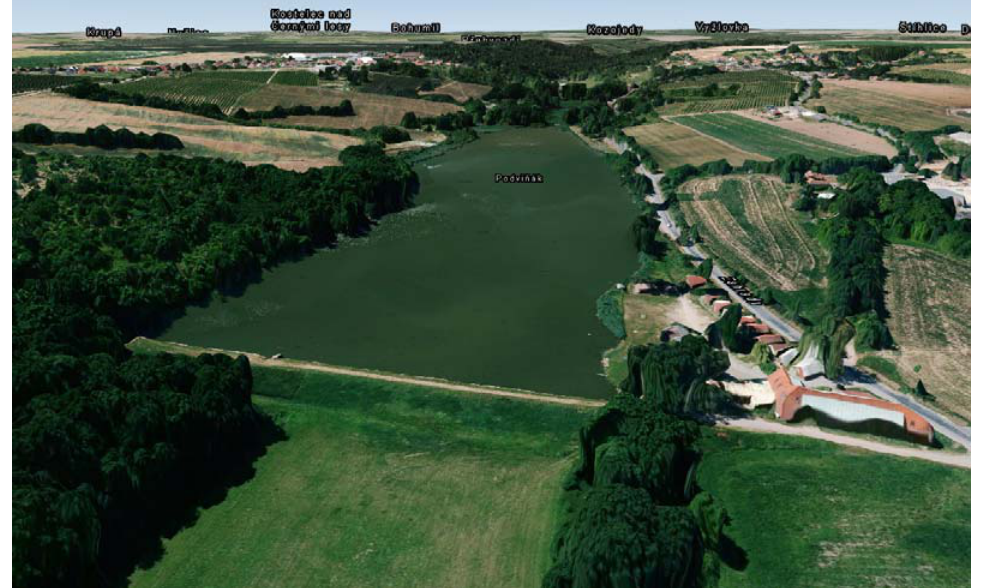
Figure 1. Overview of the Podvinak Fishpond